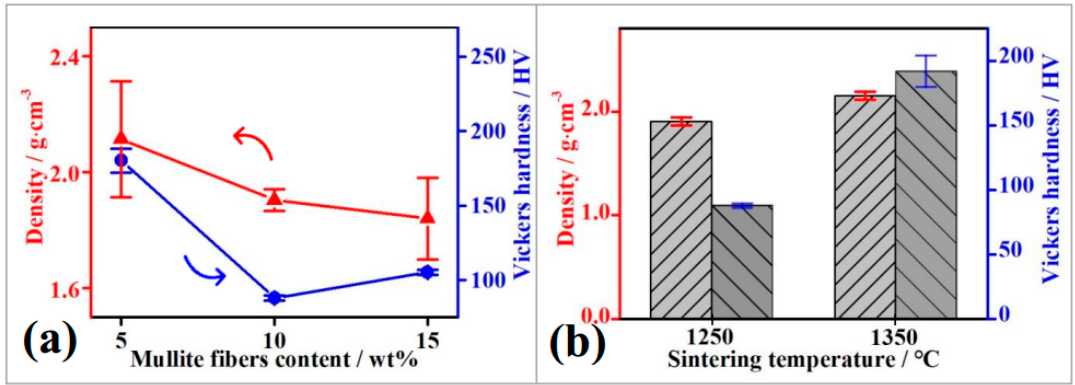
Figure 7. Bulk density and Vickers hardness of MF/HA composites ( a ) with 5 wt%, 10 wt%, and 15 wt% MF addition; ( b ) sintering at 1250 °C and 1350 °C with 10 wt% MF addition.